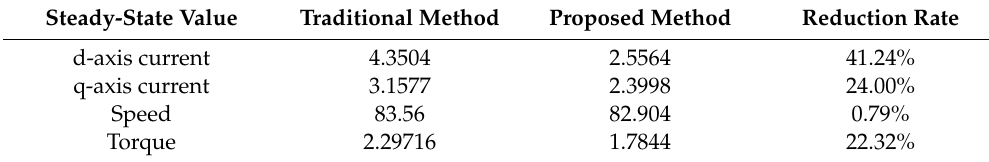
Table 2. The comparison of SD without parameter mismatches.